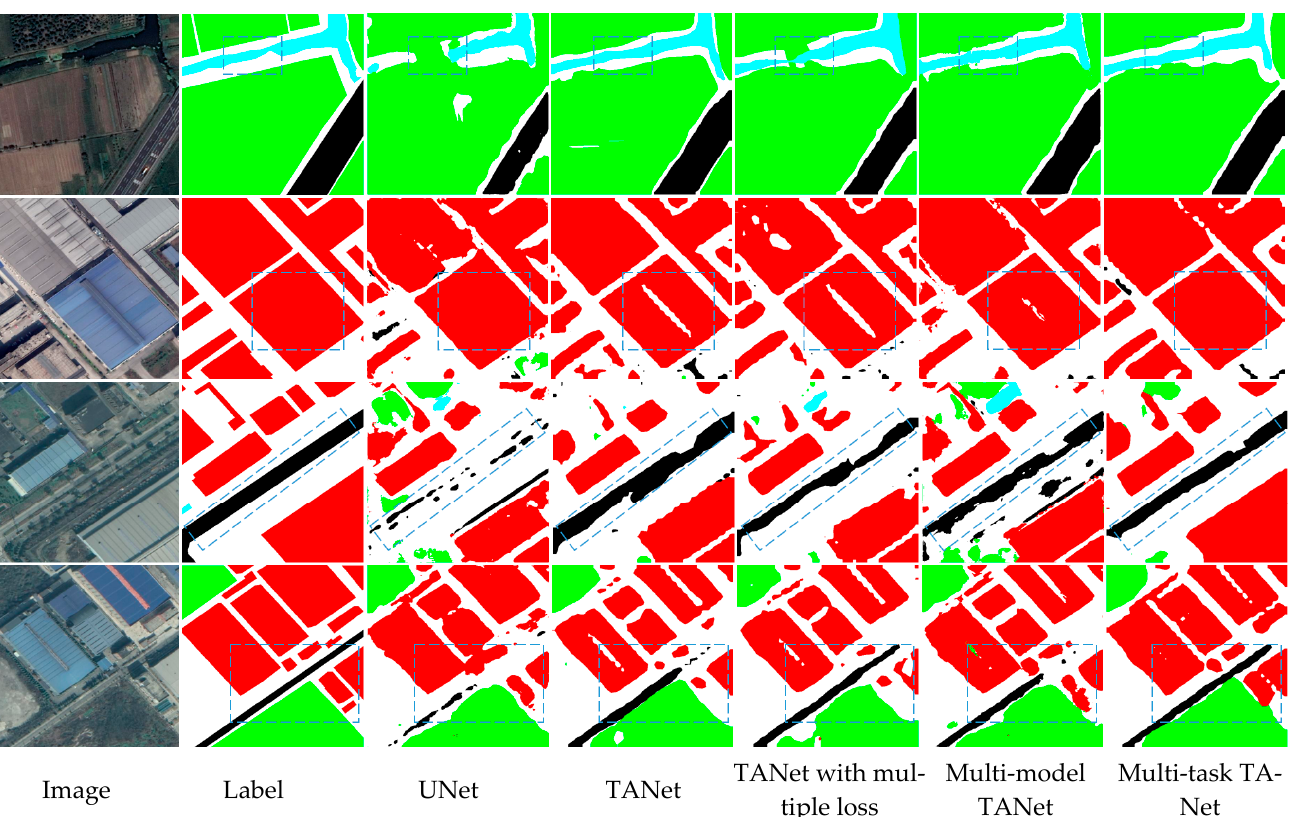
Figure 12. Examples of semantic segmentation results on ablation study of multi-task learning (CZ-WZ dataset). Table 7. Mean F1 and OA index results on edge